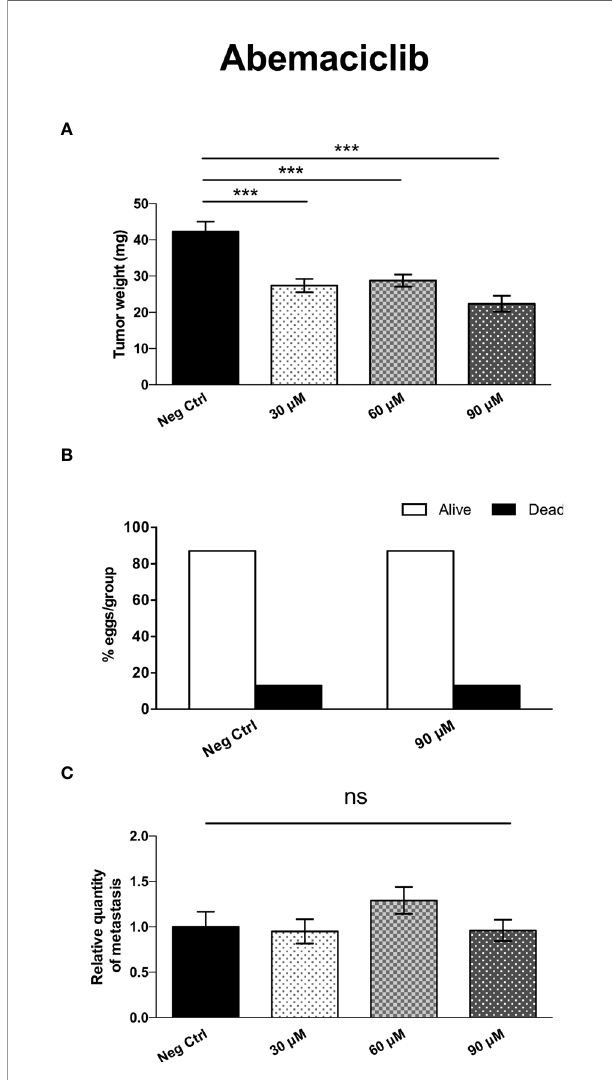
FIGURE 15 | Abemaciclib signi fi cantly inhibits tumor growth, without preventing cancer cell metastasis. (A) MDA-MB-231 cells and the well-established chorio- allantoic membrane (CAM) assay in chicken eggs were used to quantitatively measure tumor growth. See Materials & Methods for speci fi c details. After 8 days of Abemaciclib administration, on day E18 all tumors were weighed. Note that Abemaciclib signi fi cantly inhibited tumor growth, by nearly 50%, at a concentration of 90 m M (n > 11). Averages are shown ± SEM. ***p < 0.001. Statistical analysis was conducted using ANOVA. (B) Note that Abemaciclib was non-toxic, as compared to the vehicle alone control (n > 15), up to 90 m M. (C) MDA-MB-231 cells and the well-established chorio-allantoic membrane (CAM) assay in chicken eggs were used to quantitatively measure spontaneous tumor cell metastasis. See Materials & Methods for speci fi c details. After 8 days of drug administration, the Lower CAM was collected to evaluate the number of metastatic cells, as analyzed by qPCR with speci fi c primers for Human Alu sequences. Note that Abemaciclib did not show any signi fi cant effects on MDA- MB-231 metastasis, at concentrations up to 90 m M (n = 8). Averages are shown + SEM. ns, not signi fi cant. Statistical analysis was conducted using